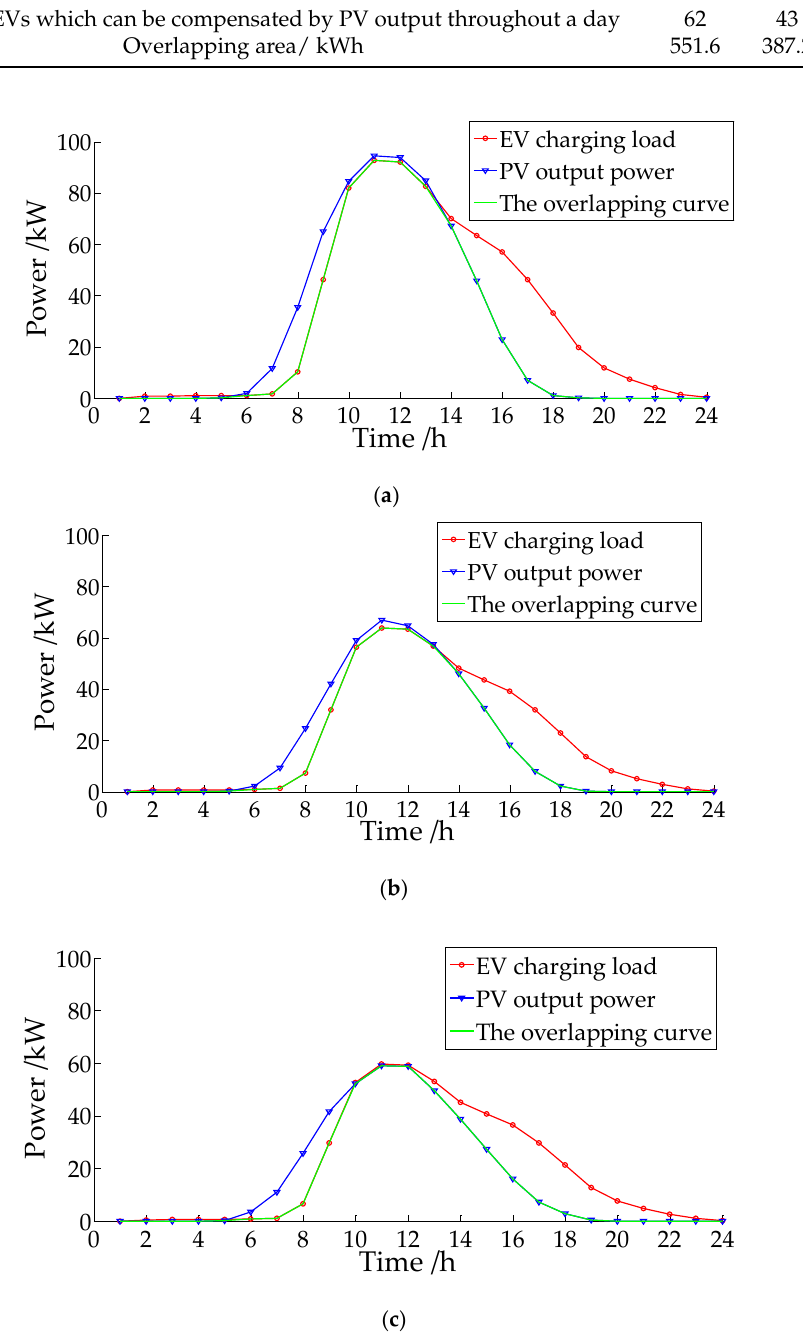
Figure 11. Optimal results of quantity bounds under each weather type. ( a ) Optimal result on sunny day; ( b ) optimal result on cloudy day; ( c ) optimal result on rainy day.